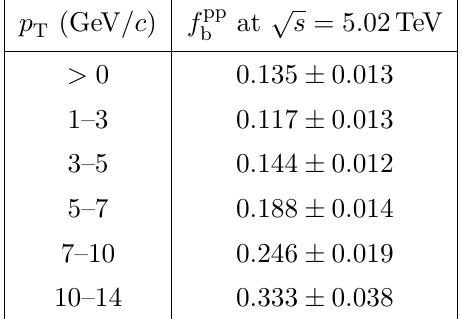
√ s = 5 . 02 TeV computed in different